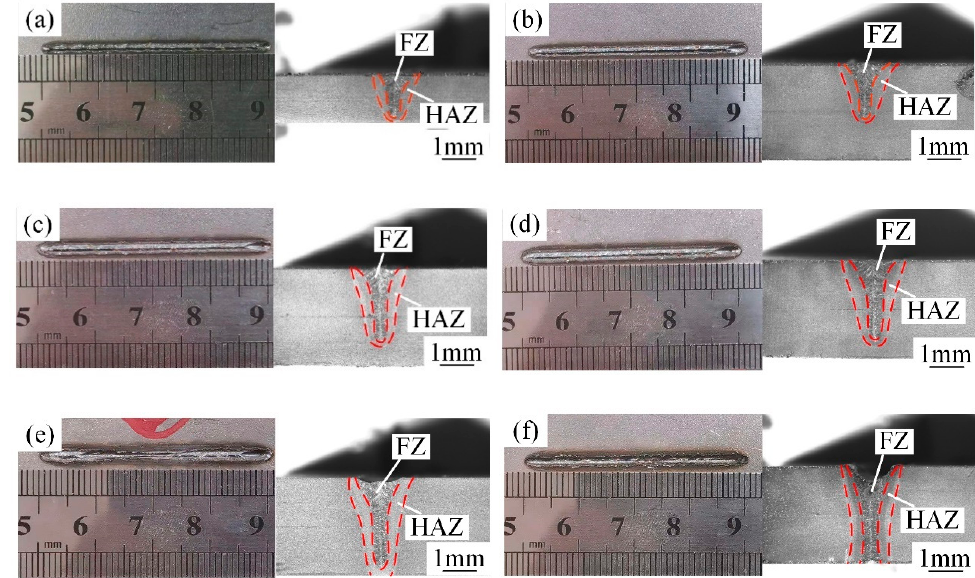
Figure 4. The front morphology and cross-section morphology of the weld under different laser powers (W): ( a ) 1800, ( b ) 2400, ( c ) 3000, ( d ) 3600, ( e ) 4200 and ( f ) 4800.